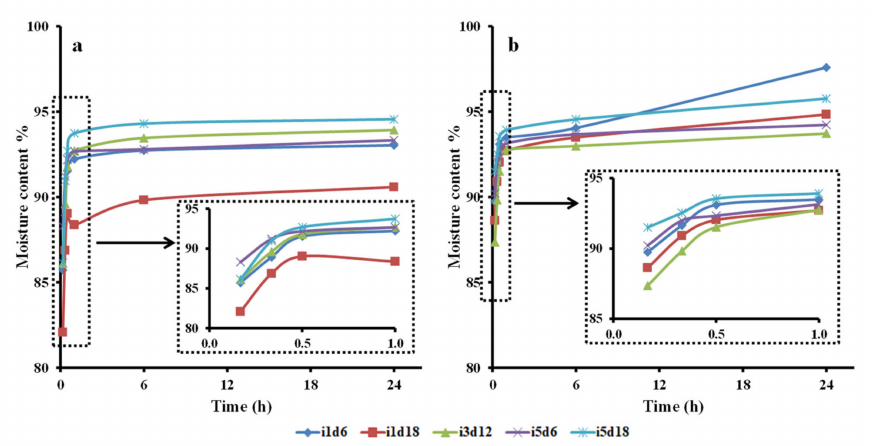
Figure 5. Moisture content of dry and moist BC membranes over 24 h. ( a )—moist BC membrane; ( b )—dry BC membrane; i—inoculum, d—harvest day; the number following “i” stands for inoculum volume 1, 3, 5 mL and the number following “d” represents the harvest day 6, 12, 18 days. The diameter of the fibrils in the BC membranes is in direct correlation with the moisture content (r = 0.431; p = 0.018). The matrix of BC membranes consists of